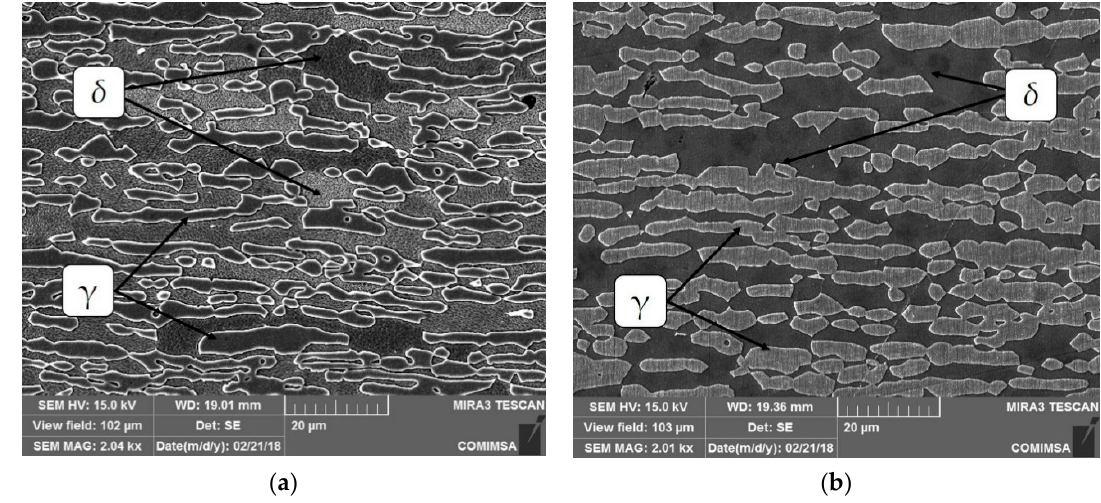
Figure 3. Base metal microstructure observed by scanning electron microscope (SEM): ( a ) SDSS 2304 and ( b ) SDSS 2507. δ : ferrite phase; γ : austenite phase.